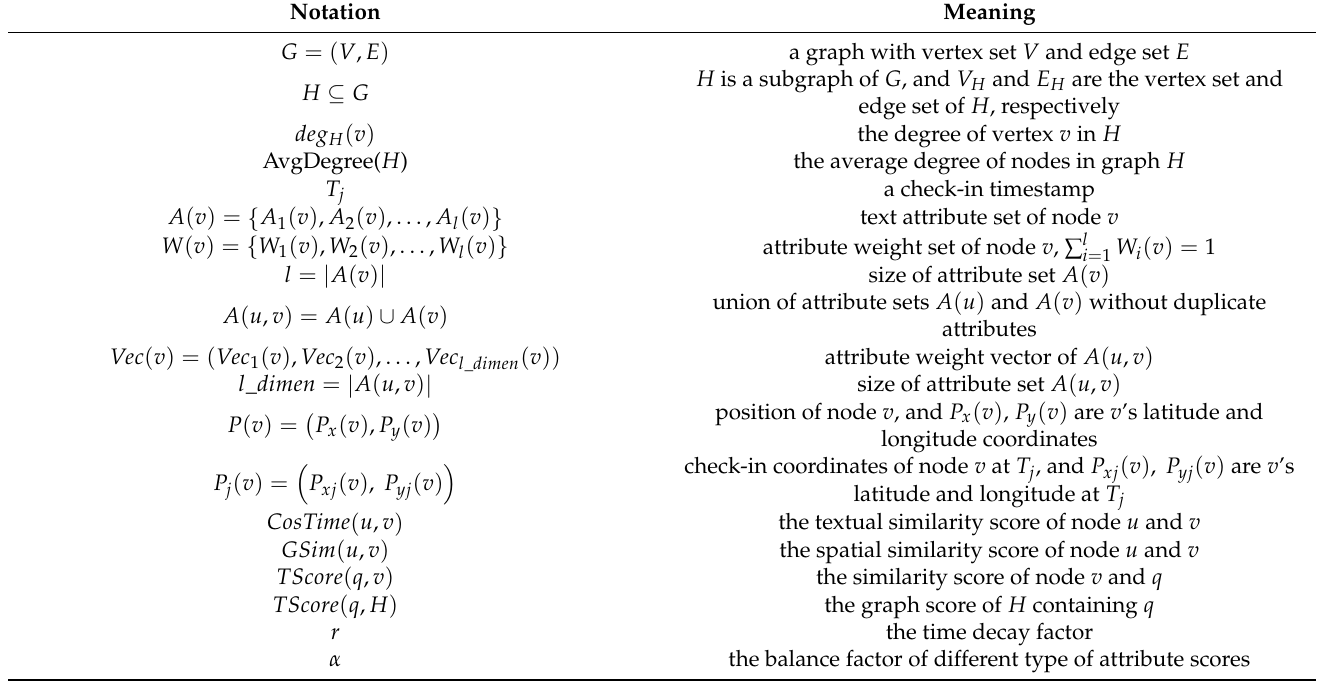
Table 1. Notations and